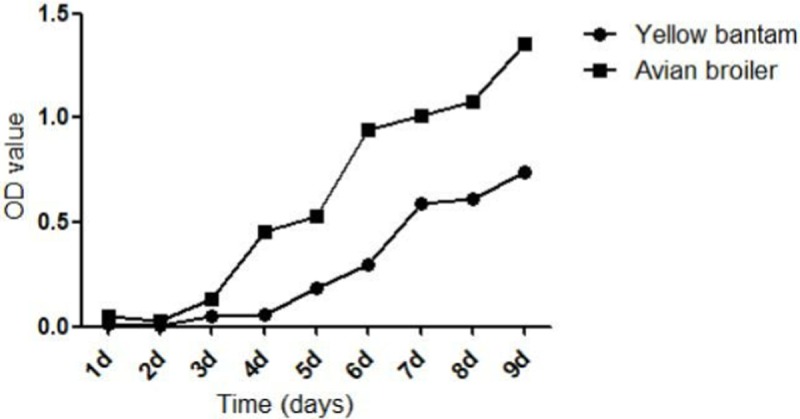
Growth curves of two breeds cartilage cells had no significant difference.The growth curves of cells were typically sigmoidal, with cell density reflected by the vertical axis. The growth curve consisted of a latent phase, a logarithmic phase, and a plateau phase (n = 3).